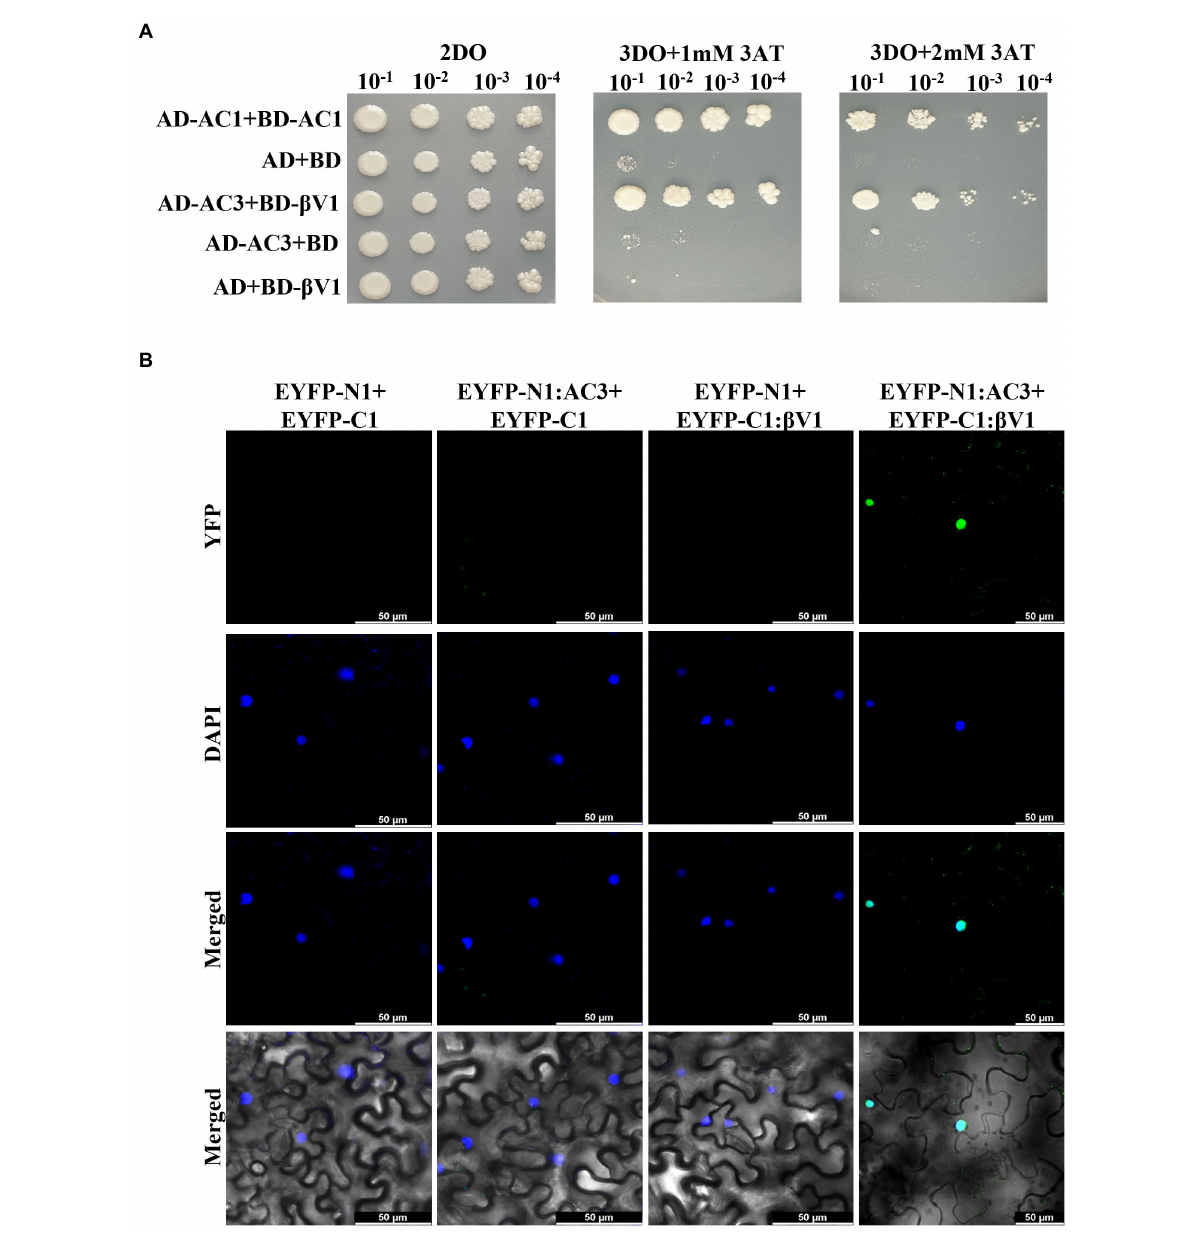
β V1 interacts with the AC3. (A) The yeast strain AH109 cells were co-transformed with different combinations of plasmids expressing AD-AC1+BD- AC1, AD+BD, AD-629 AC3+BD- β V1, AD-AC3+BD, or AD+BD- β V1. The co-transformed cells were grown on synthetic dropout media (2DO) or selection medium SD-Leu-Trp-His supplemented with either 1 mM or 2 mM 3-amino-1,2,4-triazole after serial dilutions from cultures of OD 1.0 at 600 nm. AD-AC1+BD-AC1 combination served as a positive control, while AD+BD combination acted as negative control. (B) Agrobacterium strain GV3101 harboring different combinations of BiFC constructs were co-infiltrated into leaves of benthamiana plants. After 48 h post infiltration, epidermal cells of leaves were visualized by confocal microscopy to detect the reconstituted YFP fluorescence. The nucleus was stained with DAPI. Row 1 shows YFP fluorescence. Row 2 shows DAPI fluorescence, while row 3 and 4 represents the merged images without and with DIC images, respectively. Scale bars represents 50 μ